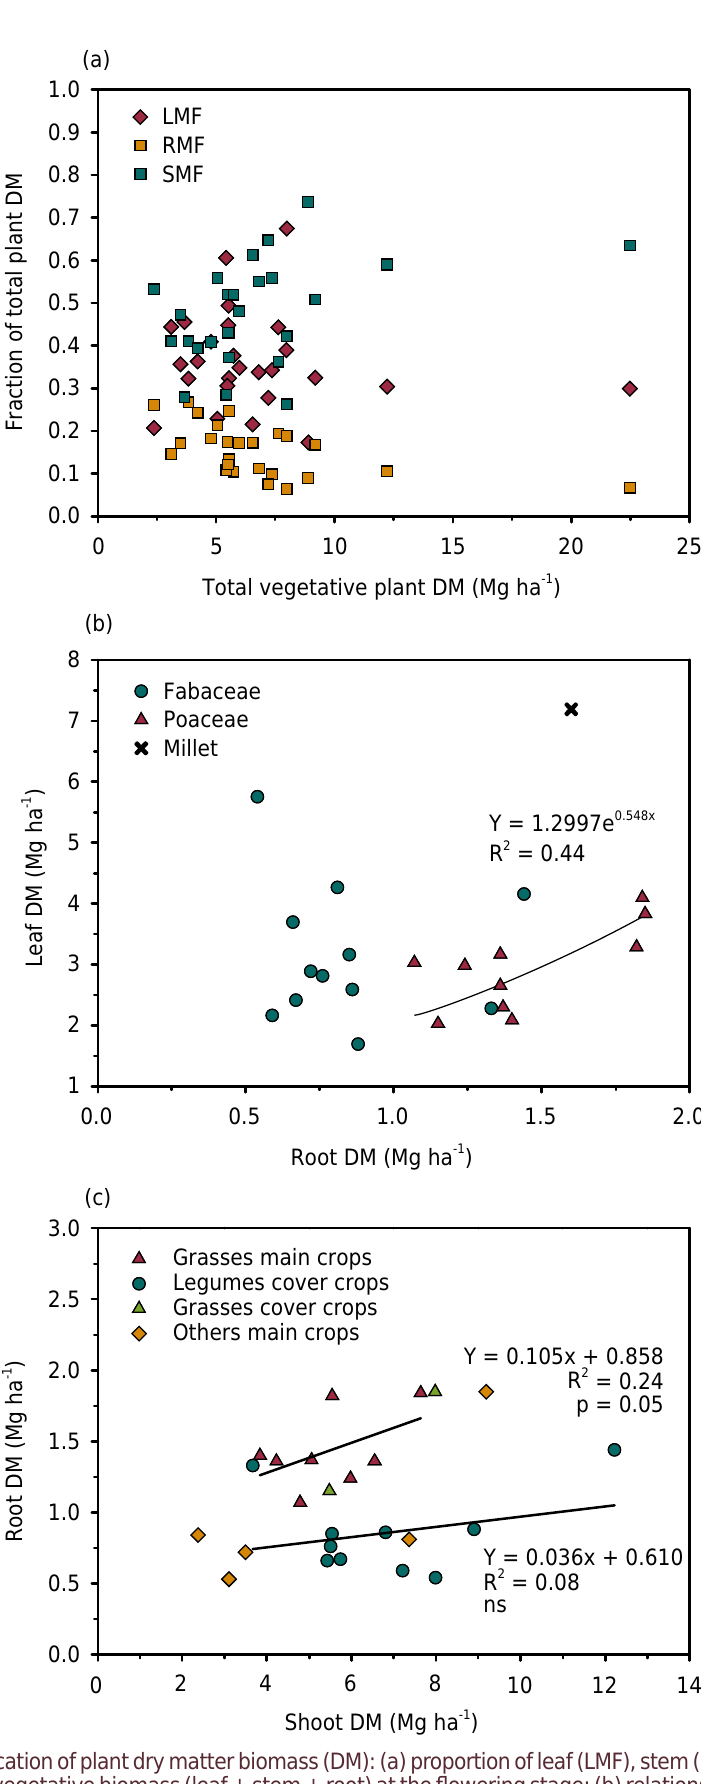
Figure 1. Allocation of plant dry matter biomass (DM): (a) proportion of leaf (LMF), stem (SMF), and root (RMF) to total vegetative biomass (leaf + stem + root) at the flowering stage; (b) relationships between leaf and root biomass at the flowering stage for the Poaceae and Fabaceae species; (c) relationships between root biomass and shoot biomass at flowering or maturity stages for the different